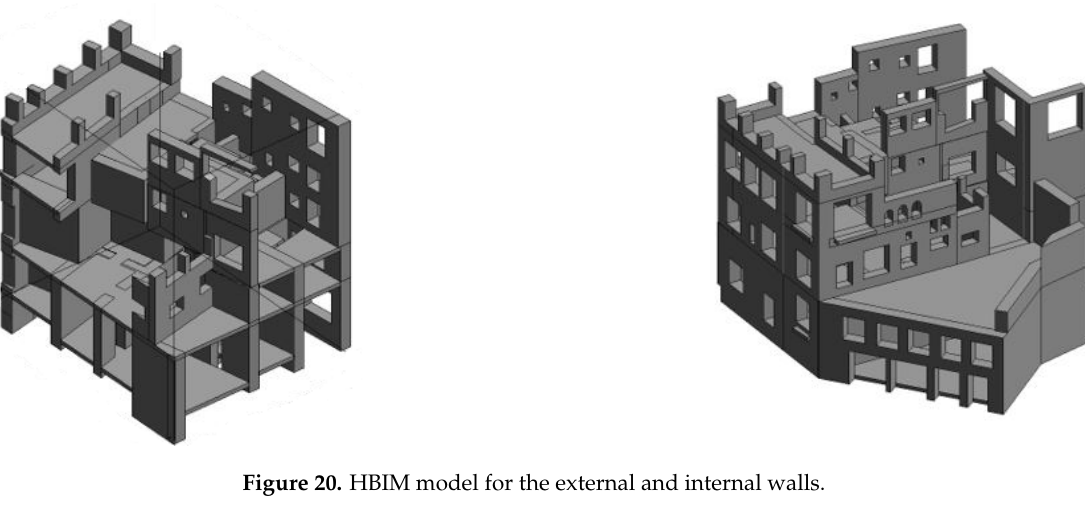
Figure 19. From enhanced point clouds to a HBIM model—Matbouli House Museum. ( a , b ) Longitudinal and transversal cross-sections in point clouds. ( c ) Set of grids created on the planimetry. ( d – h ) Examples of different BIM elements.